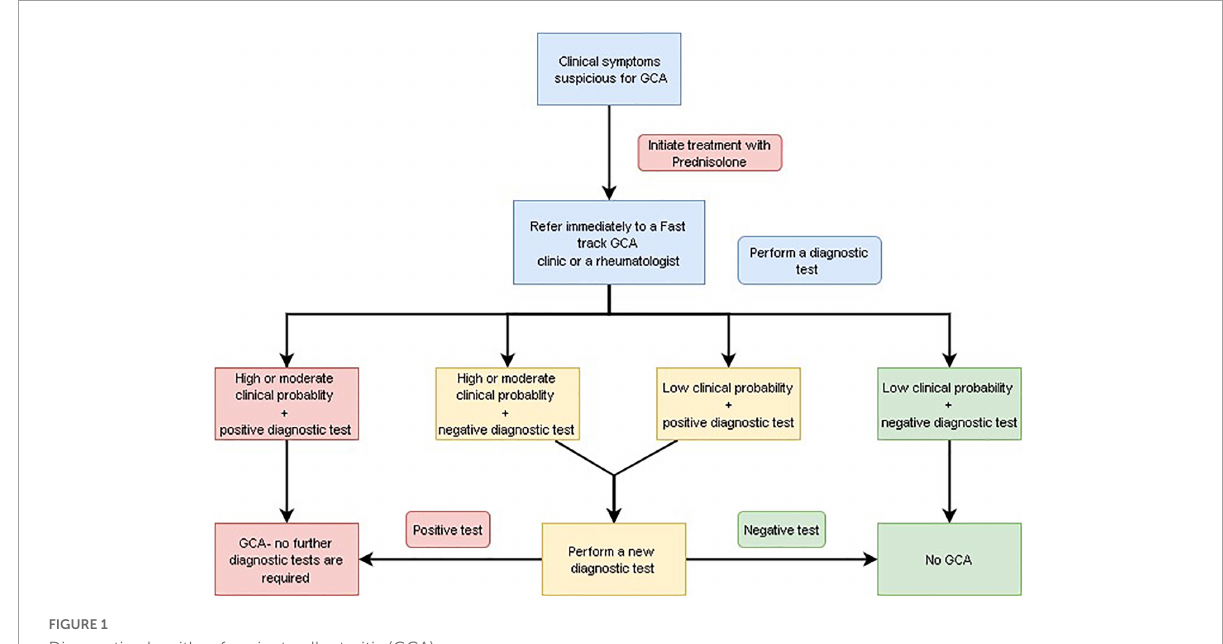
FIGURE1 Diagnostic algorithm for giant cell arteritis (GCA).